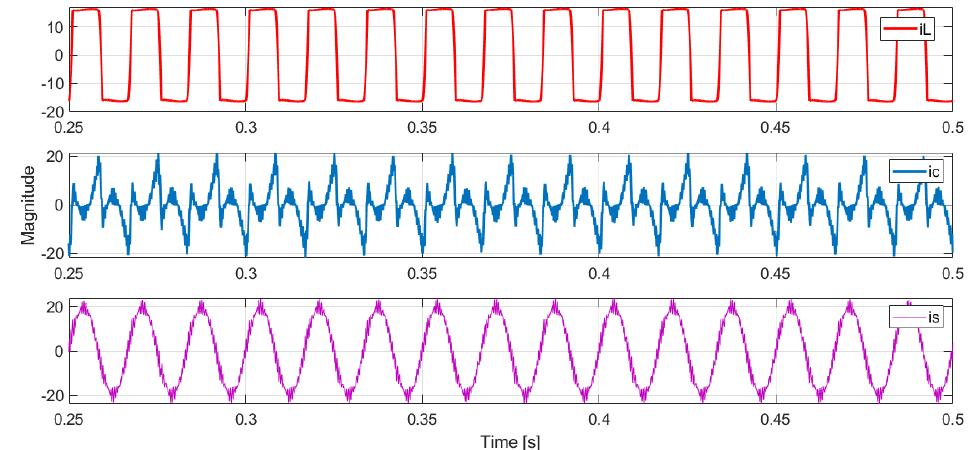
Figure 11. Nanogrid system currents operating in connected mode: i L Load current R L ; mains current drain of grid power I S and I C compensation